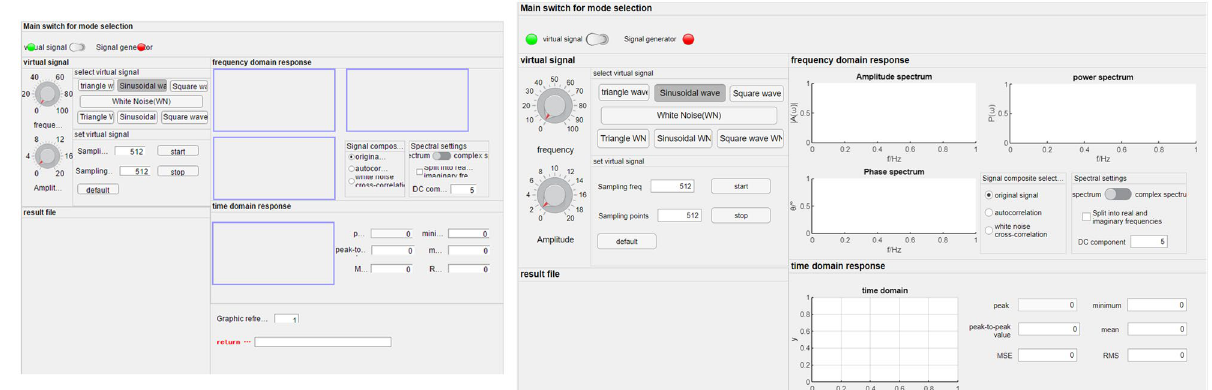
Figure 1. Loading applications on Chrome browser versions 49(left) and 99(right).